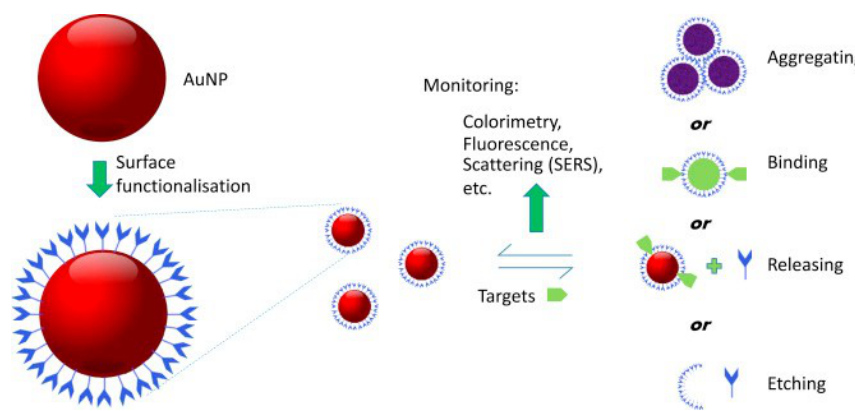
Figure 2. Gold nanoparticle-based sensing in analytical science. Reproduced with permission from reference [51].